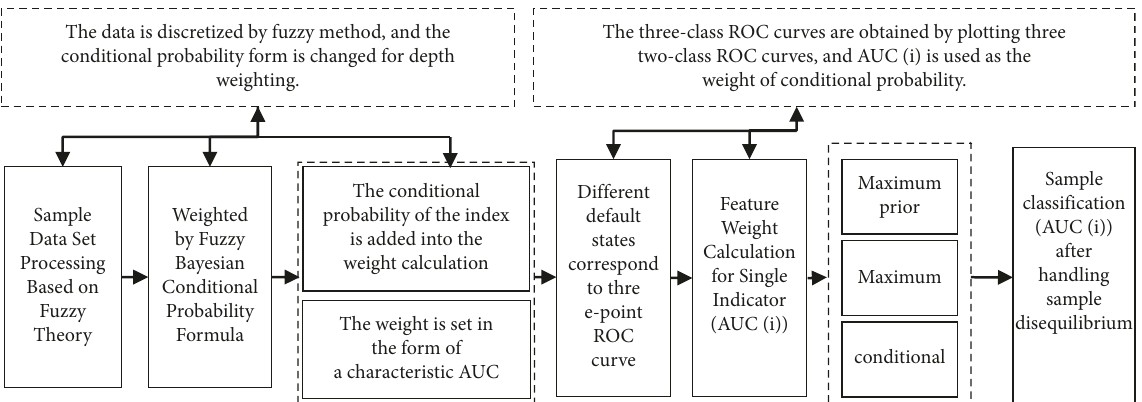
Figure 2: Principle for solving difficulty two.